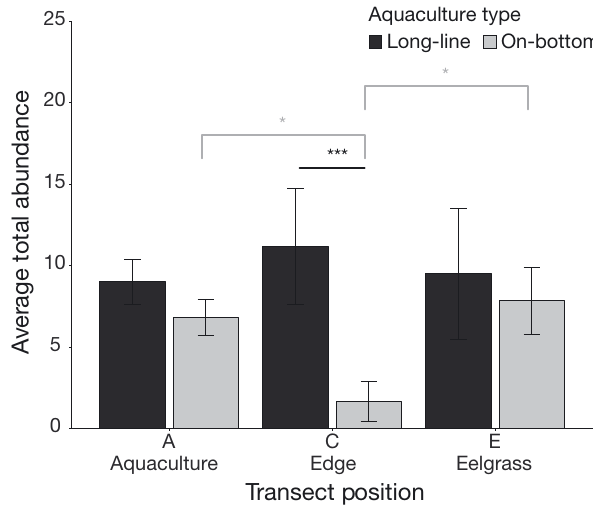
Fig. 5. Average (±1 SE) catch of fish and crabs in minnow traps across the transects and between aquaculture types (N = 6). Brackets show significant contrasts of interest from simultaneous comparisons of all pairs significance: *p <